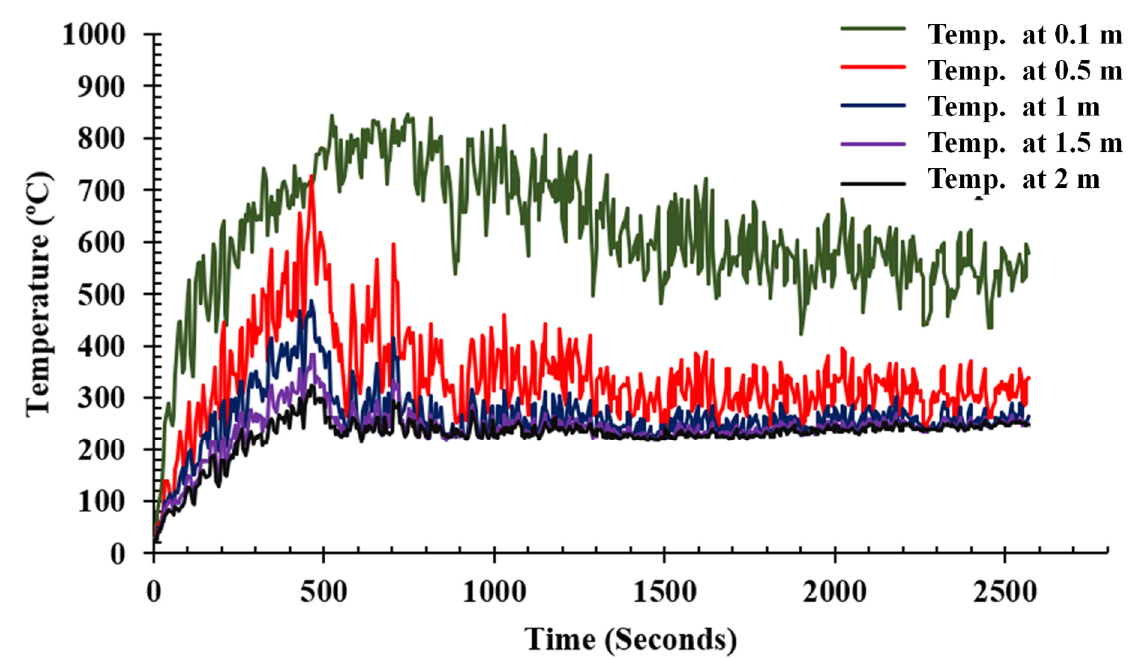
Figure 7. The temperature along the horizontal centerline at different heights above the plume for the 2 m 2 methanol pool fire.